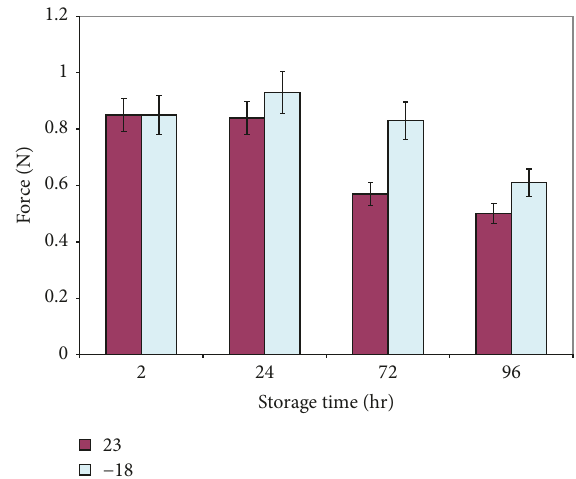
Figure 1: Relationship between tearing force and storage time for PB at different storage temperatures.